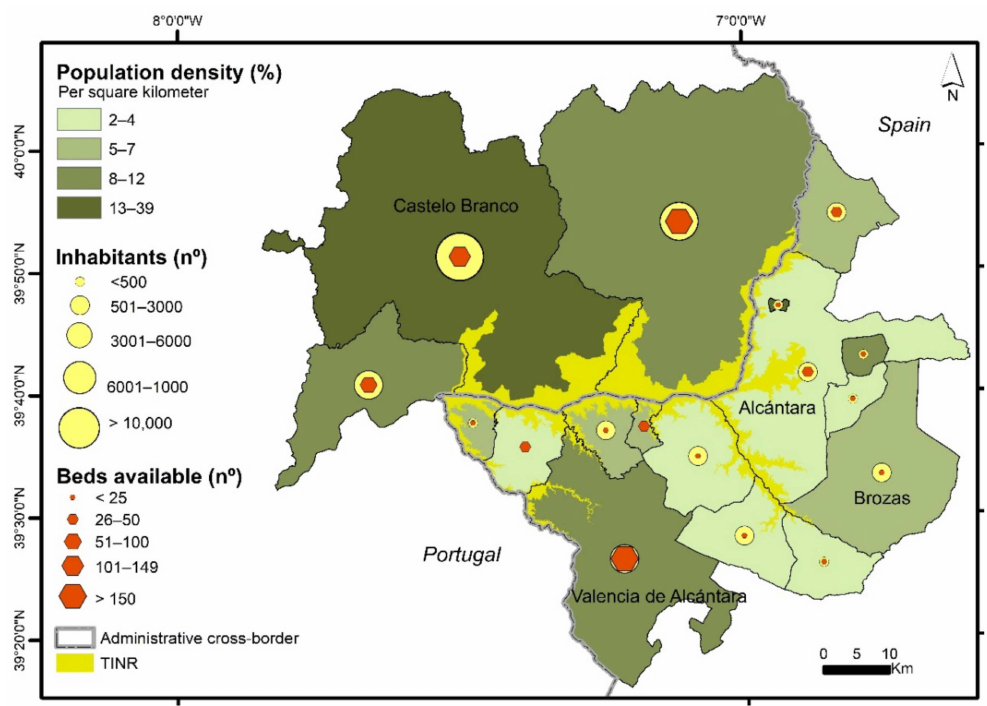
Figure 1. Inhabitants and population density in the study area. Data source: IEEX (www.ciudadano. gobex.es, accessed on 10 March 2022); PORDATA (www.pordata.pt, accessed on 10 March